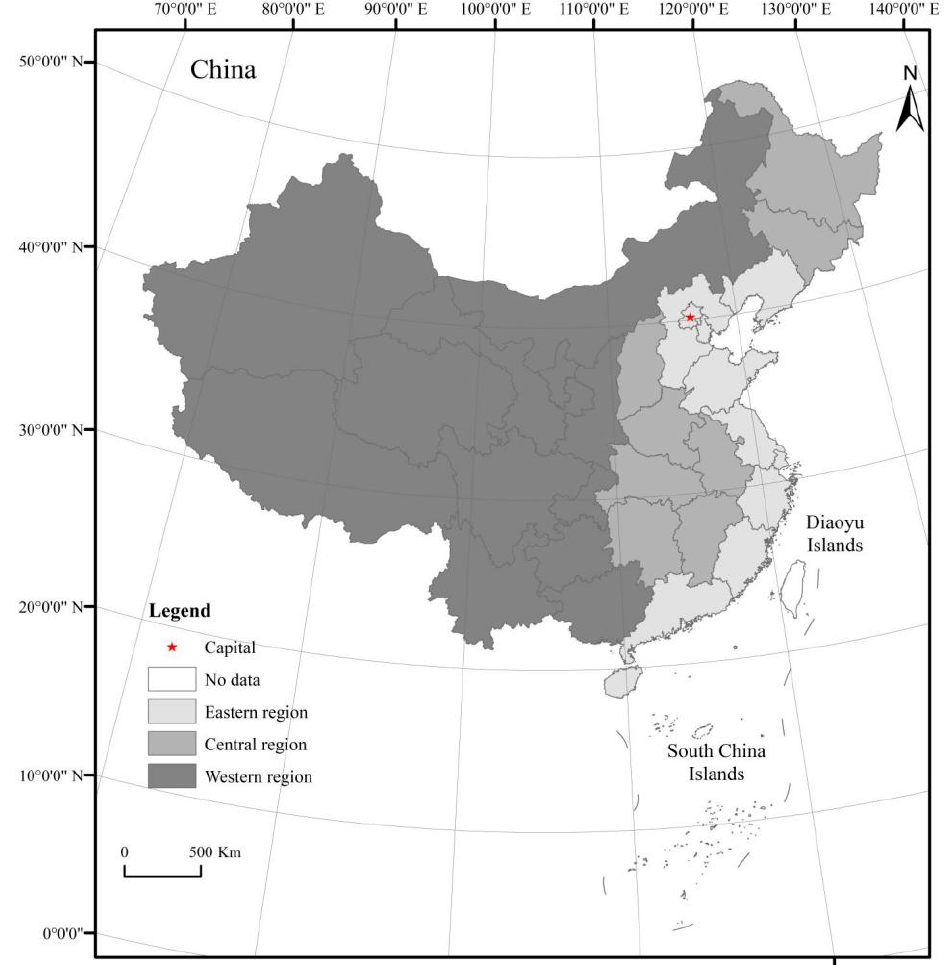
Figure 1. Study Figure 1. Study area.